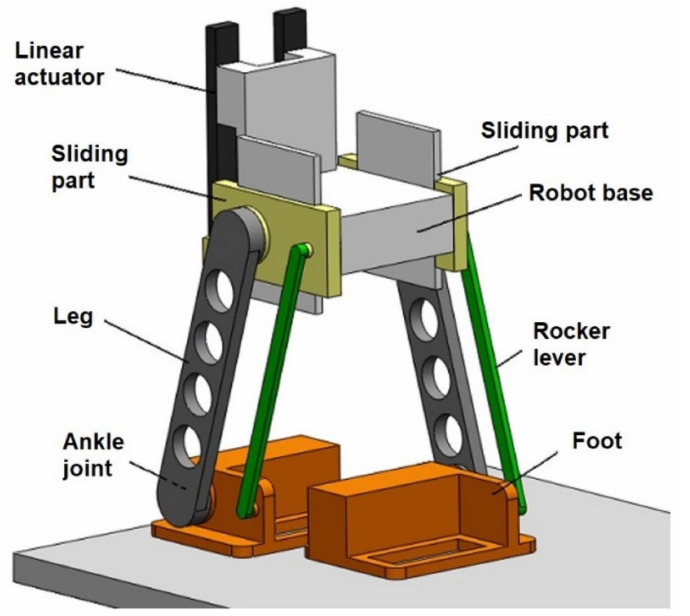
Figure 1. Model of the designed biped robot